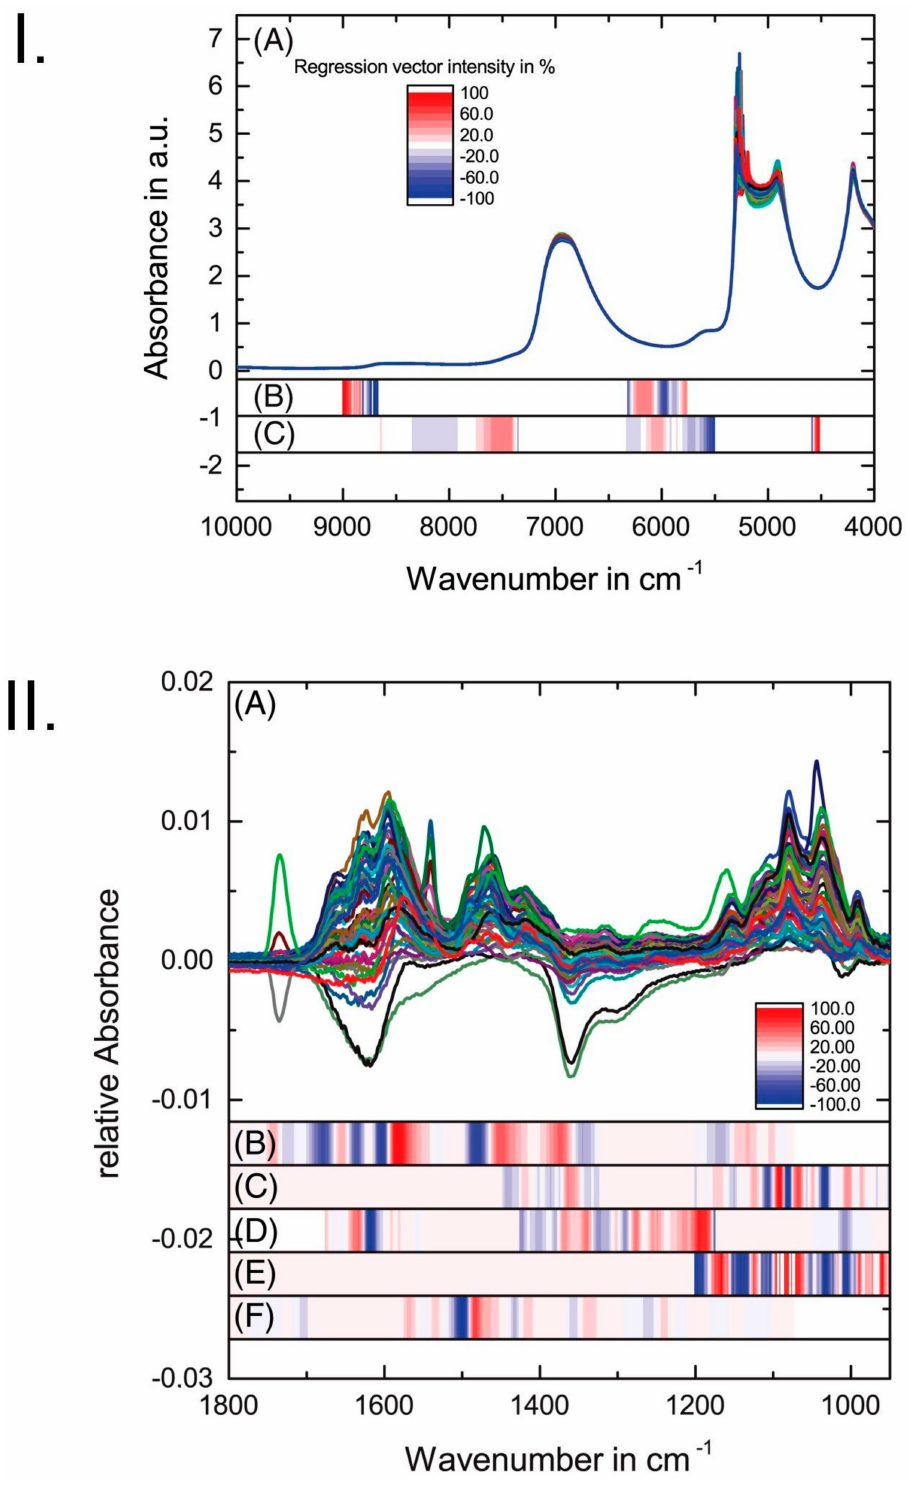
Figure 2. Dissection of the PLS regression vectors developed by Henn et al. [33] for prediction of blood constituents from NIR absorbance ( I.A ) and IR di ff erence ( II.A ) spectra of a 5-component model mixture in artificial dialysate solutions. Relative (to the maximum value) intensity of the regression vector for glucose ( B ) and urea ( C ), lactate ( D ), phosphate ( E ) and creatinine ( F ). Adapted in agreement with CC BY 4.0 license, Ref.